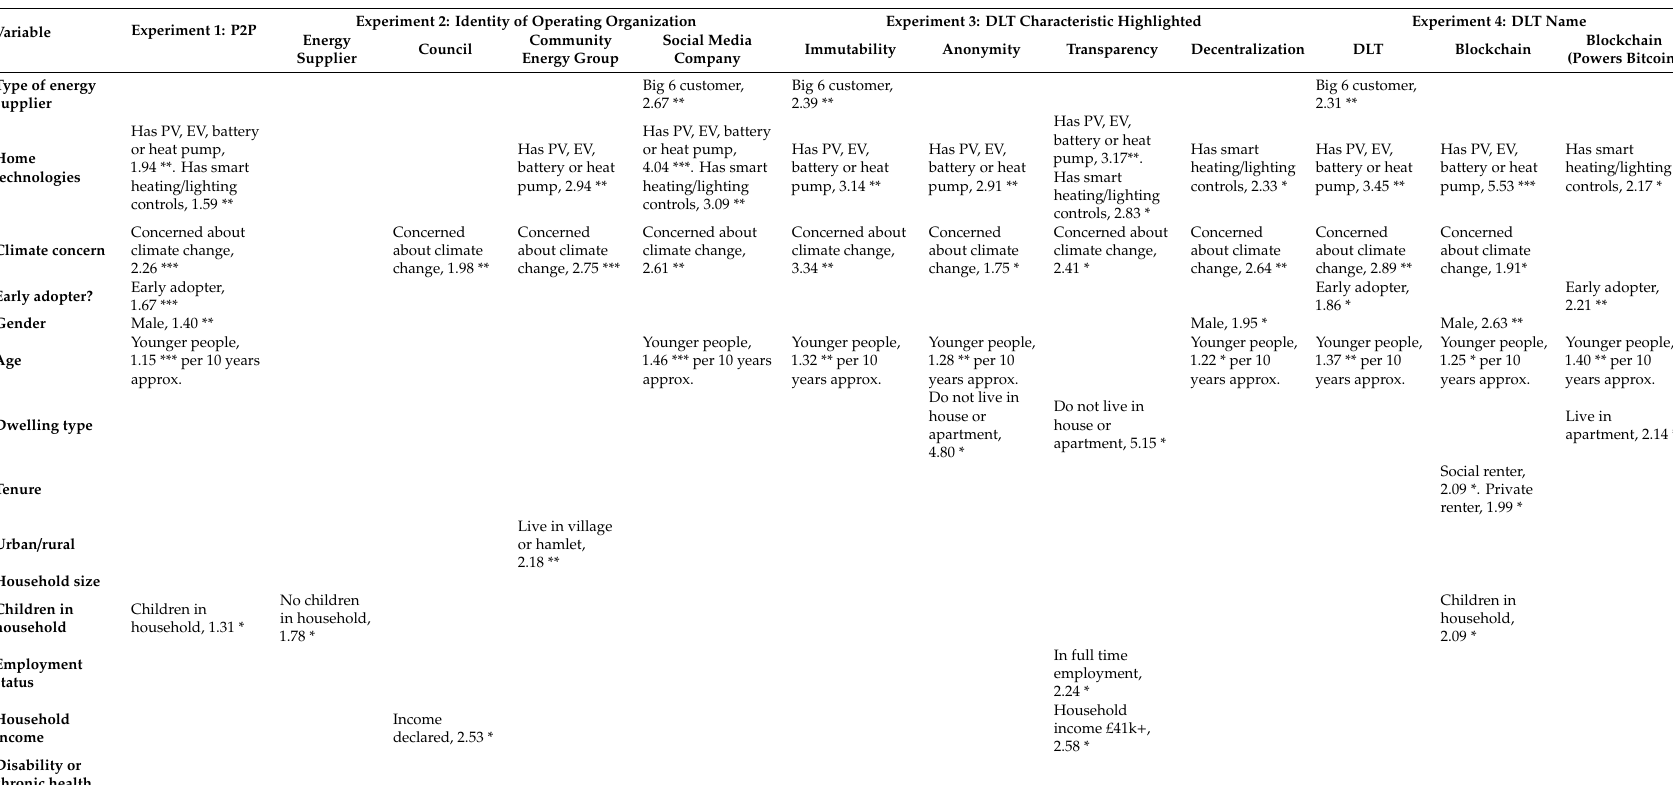
Table 6. Logistic regression table showing only demographic and other variables which have a statistically significant association with selecting ‘more likely’ to participate (as compared with other outcomes) in all experiments. For Experiment 1, the main e ff ects (i.e., 25% and 75% of consumption met, neighbourhood and national spatial scale) were included in the regression to control for their e ff ects: these are not reported here. For other experiments, regressions were run separately for each experimental group. The number reported is the odds ratio, with asterisks representing p < 0.05 *, p < 0.01 **, p < 0.001